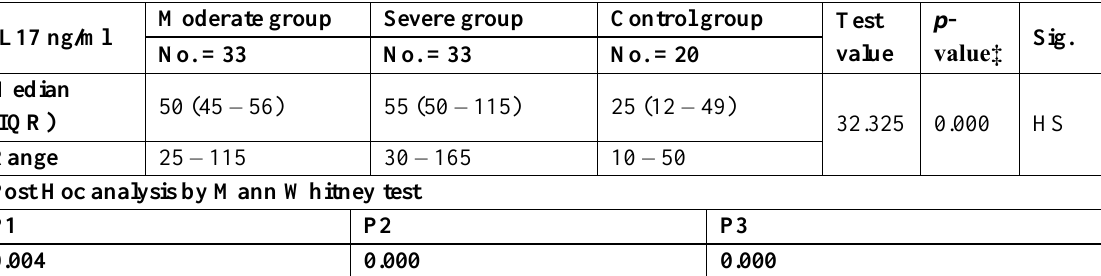
Table 1. Serum IL-17 level in patients’ groups and HCs.